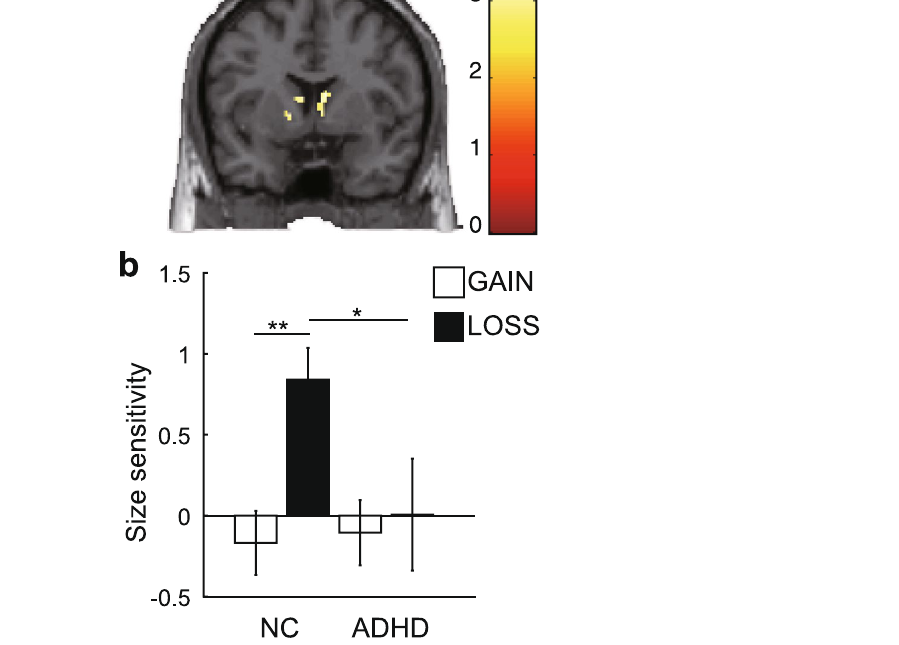
Figure 3. ( a) Result of a group comparison (NCs > ADHD) of the BOLD signal for size sensitivity in the LOSS condition (see Supplementary Table S1; P < 0.05 for visualization). ( b ) BOLD signal for size sensitivity in the GAIN (white bars) and LOSS (grey bars) conditions in the anatomically defined region of interest of the left and right caudate heads (red coloured area) ( * P < 0.05, ** P < 0.001, multiple comparison with the Tukey–Kramer method). Error bars denote ± 1 s.e.m. ( n = 17 for NCs, n = 14 for